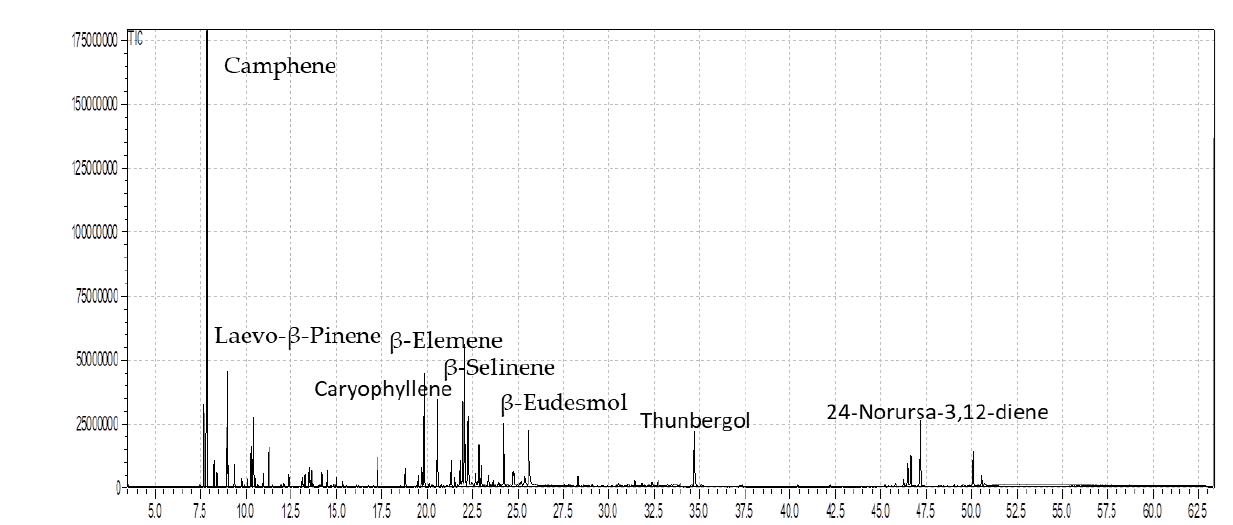
Figure 1. The GC chromatogram of the essential oils of the stem of B. hirtum.